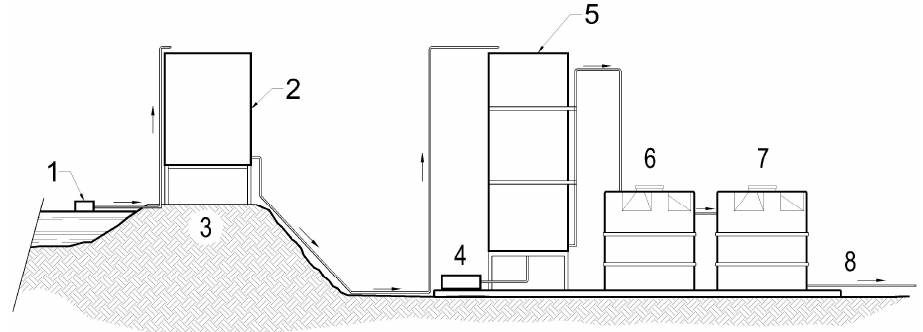
Figure 1. Schematic representation of the wastewater treatment system. (1) Pump; (2) Dilution tank; (3) Lagoon board; (4) Compressor; (5) Trickling filter; (6) Pre-clarifier; (7) Clarifier; (8) Final